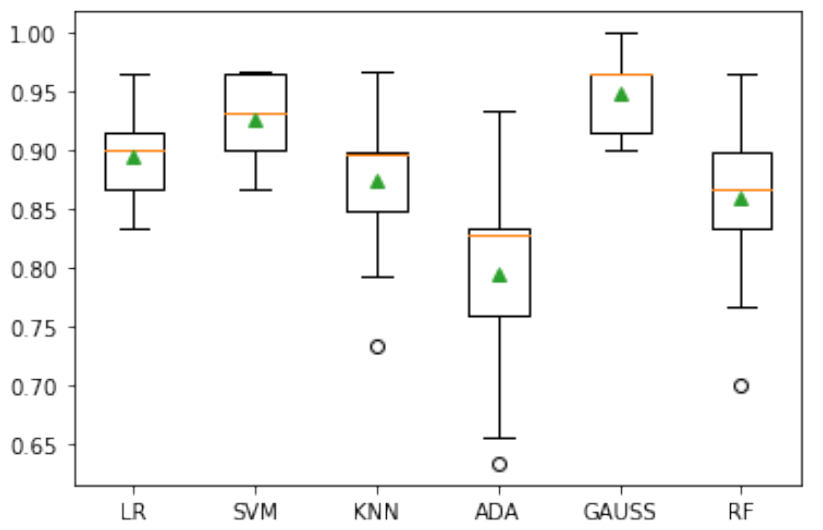
Figure 8. Comparison of the overall accuracy metric for different classifiers during the training phase of the balanced model. Note: The orange horizontal line refers to the median and the green triangle refers to the mean.